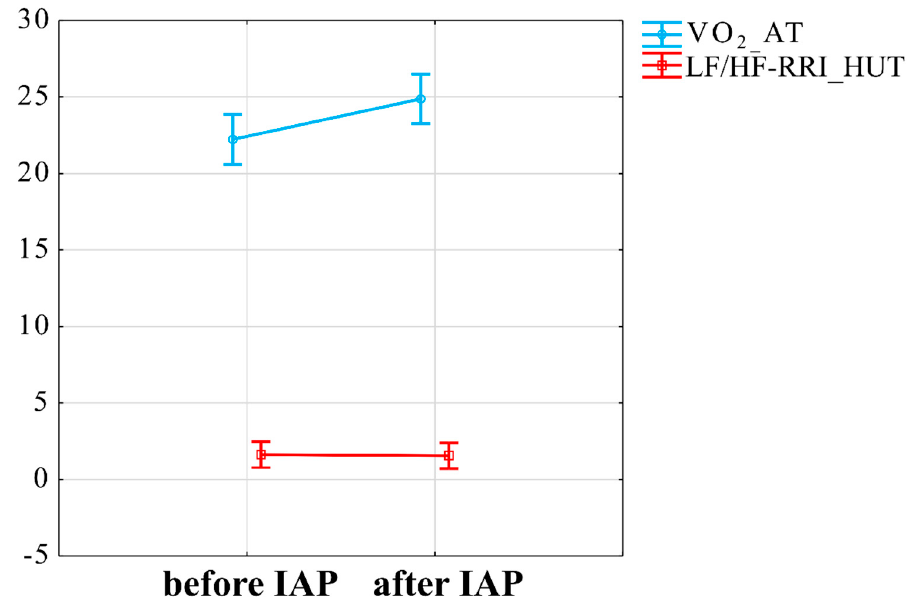
Figure 6. Interaction between influence of IAP on VO 2 subpeak and sympathovagal balance in response to head-up tilt test. VO 2 AT—maximal oxygen consumption during anaerobic threshold, LF/HF-RRI_HUTT—low frequency diastolic blood pressure to high frequency R-R interval during head-up tilt test, IAP—Individualised Activity